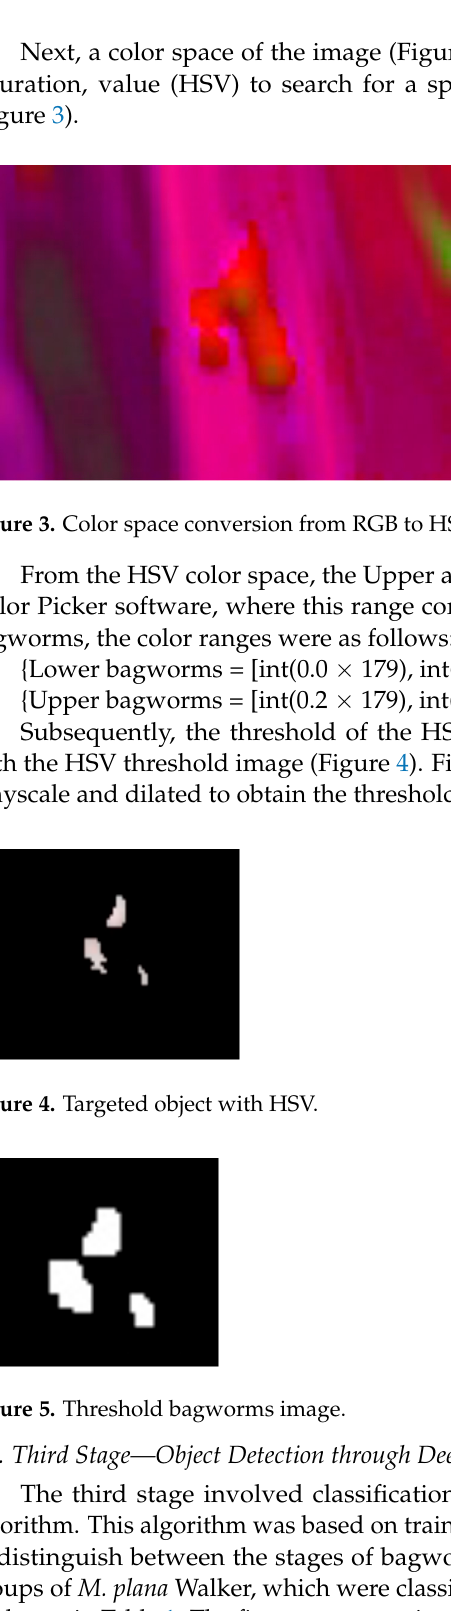
Figure 2. Morphological image processing using: ( a ) Original RGB image, ( b ) Polarized image after Pyramid mean shift filter, and ( c ) Gaussian blur filter.